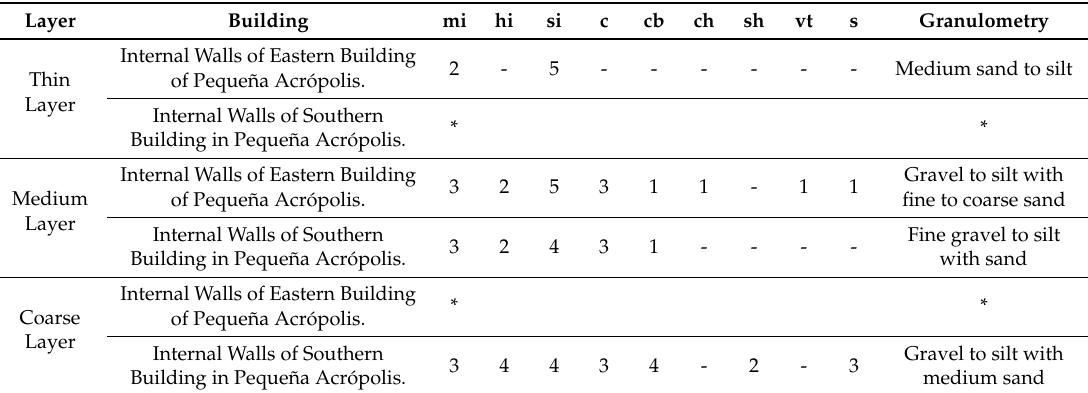
Table 6. Average frequency of inclusions in all the layers of Type 2 plasters. Average frequency of inclusions in all the layers of Type 1 plasters. mi (micritic inclusions); hi (heterogeneous inclusions); si (sparitic inclusions); c (clays); cb (carbon); ch (chert); sh (shells); vt (vegetal tissue); s (soil). 1—very scarce (less than 5%); 2—scarce (5%–15%); 3—common (15%–40%); 4—frequent (40%–70%);